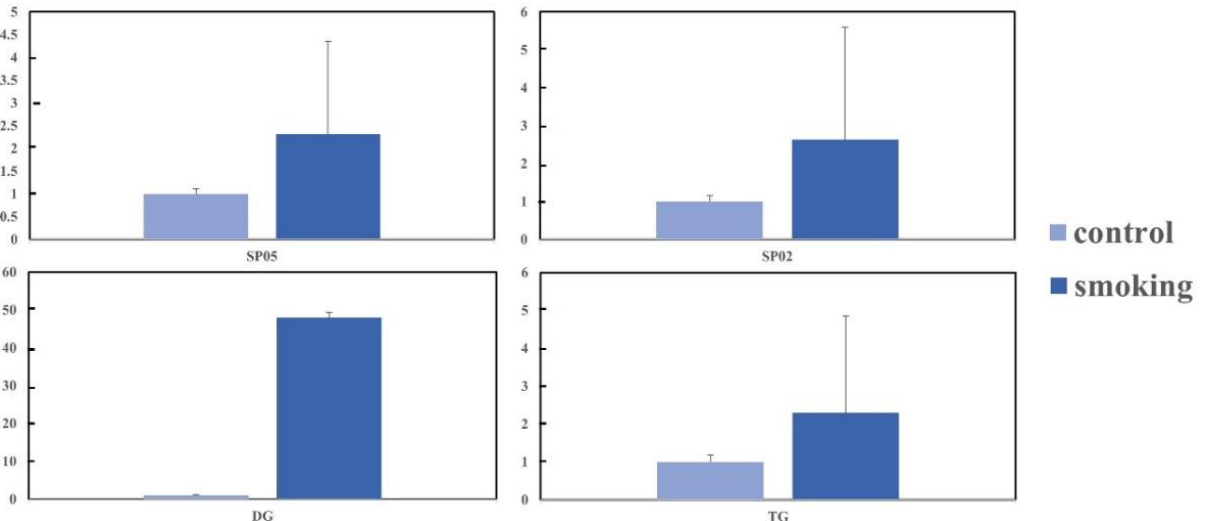
Figure 4. Comparison of differences in sphingolipids and glyceroglycolipids between the smoking and control groups. These units are ‘relative to the value for non-smokers, which is set at a value of 1’.